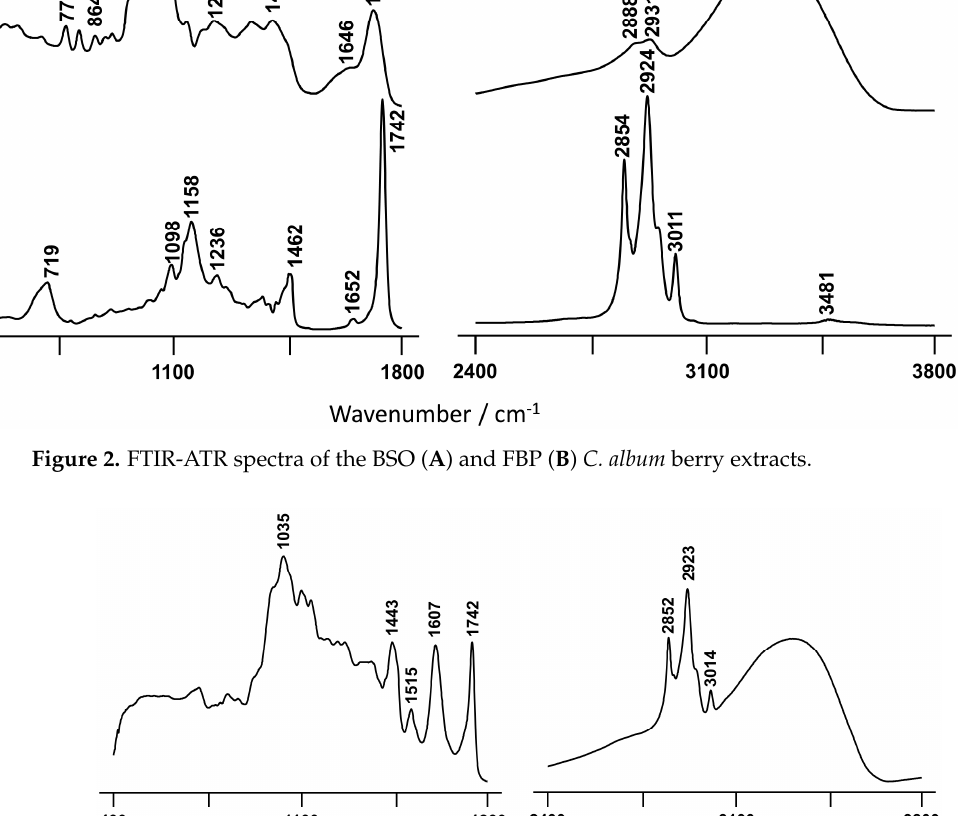
Figure 3. FTIR-ATR spectrum of the BSR C. album berry extract.